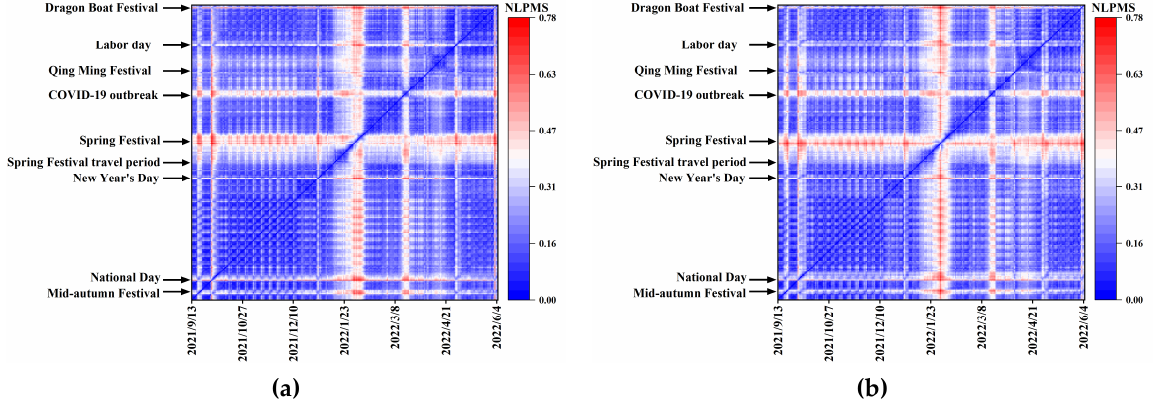
Table 4. Descriptions of different holiday periods.